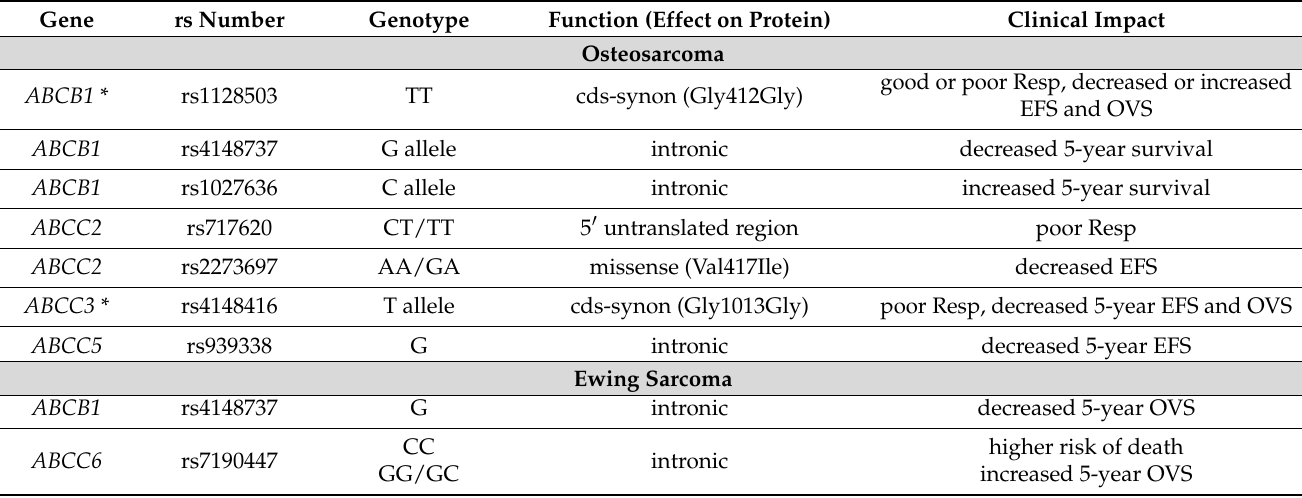
Table 1. Germline single-nucleotide polymorphisms of ABC transporters reported to be associated with responses to preoperative chemotherapy or survival in patients with osteosarcoma or Ewing’s sarcoma.